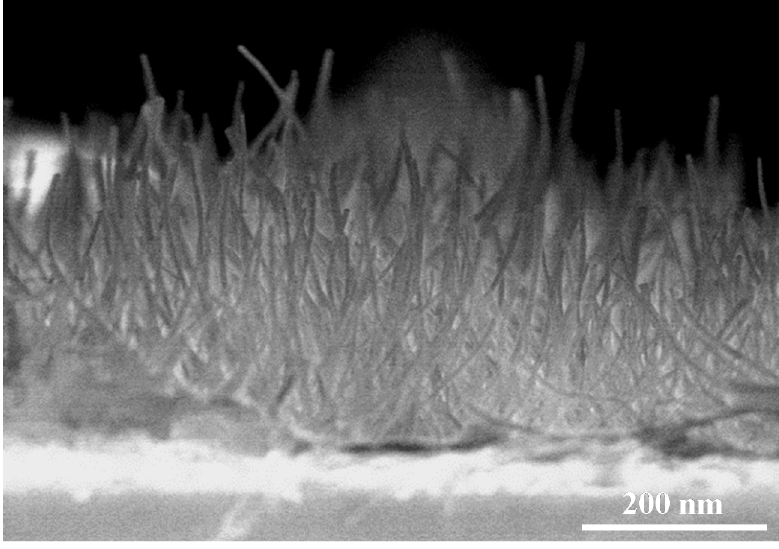
Figure 5. Zinc oxide (ZnO) nanowires without the AAO template which was removing by immersing in 0.1 M sodium hydroxide (NaOH) solution for 10 min.